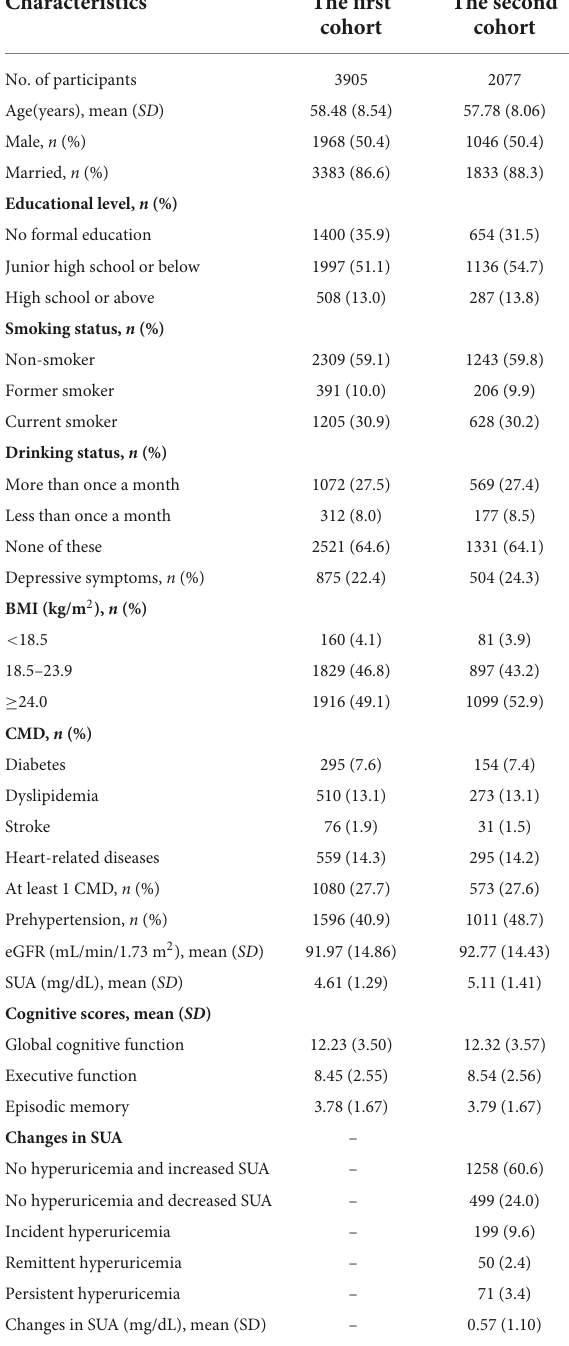
TABLE 1 Baseline characteristics of the study population in two